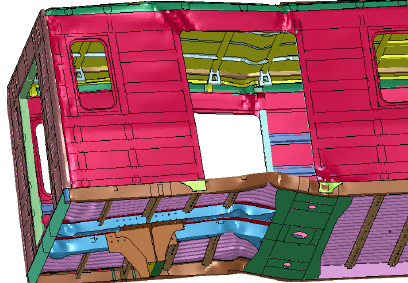
Figure 4. Deformation at end of collision